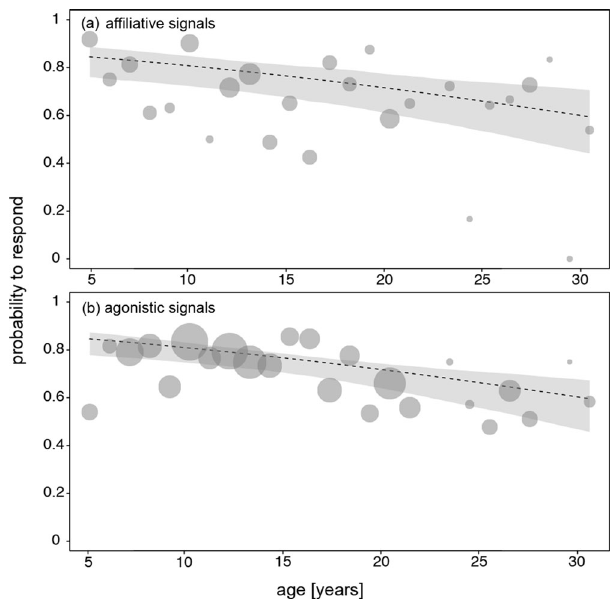
Fig. 2 Effect of receiver age on the probability of females to respond to a signal. a Probability to respond to af fi liative signals in relation to receiver age ( N = 846 events involving 50 female receivers). b Probability to respond to agonistic signals in relation to receiver age ( N = 2269 events involving 50 female receivers). The area of the points represents the number of events per age (range: 10 to 233). Dashed lines and grey polygons indicate the fi tted model and its (2.5 and 97.5%) con fi dence limits (for all other terms in the model being centred to a mean of